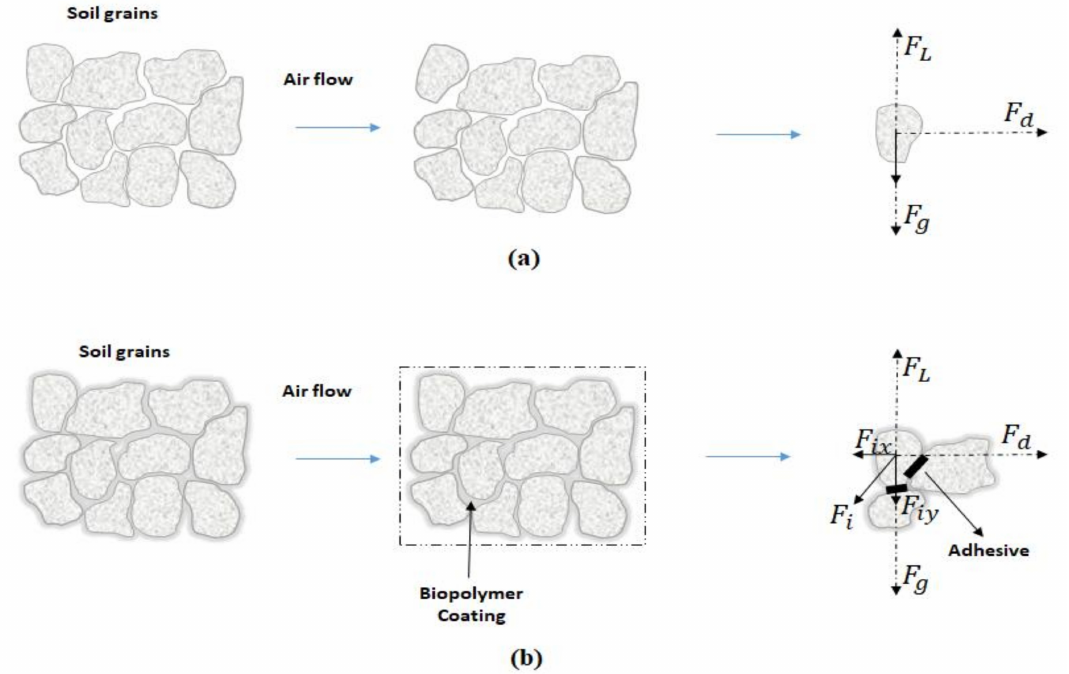
Figure 9. Mechanical trend of soil resistance against wind erosion: ( a ) sand in natural state, ( b ) biopolymer treated sand